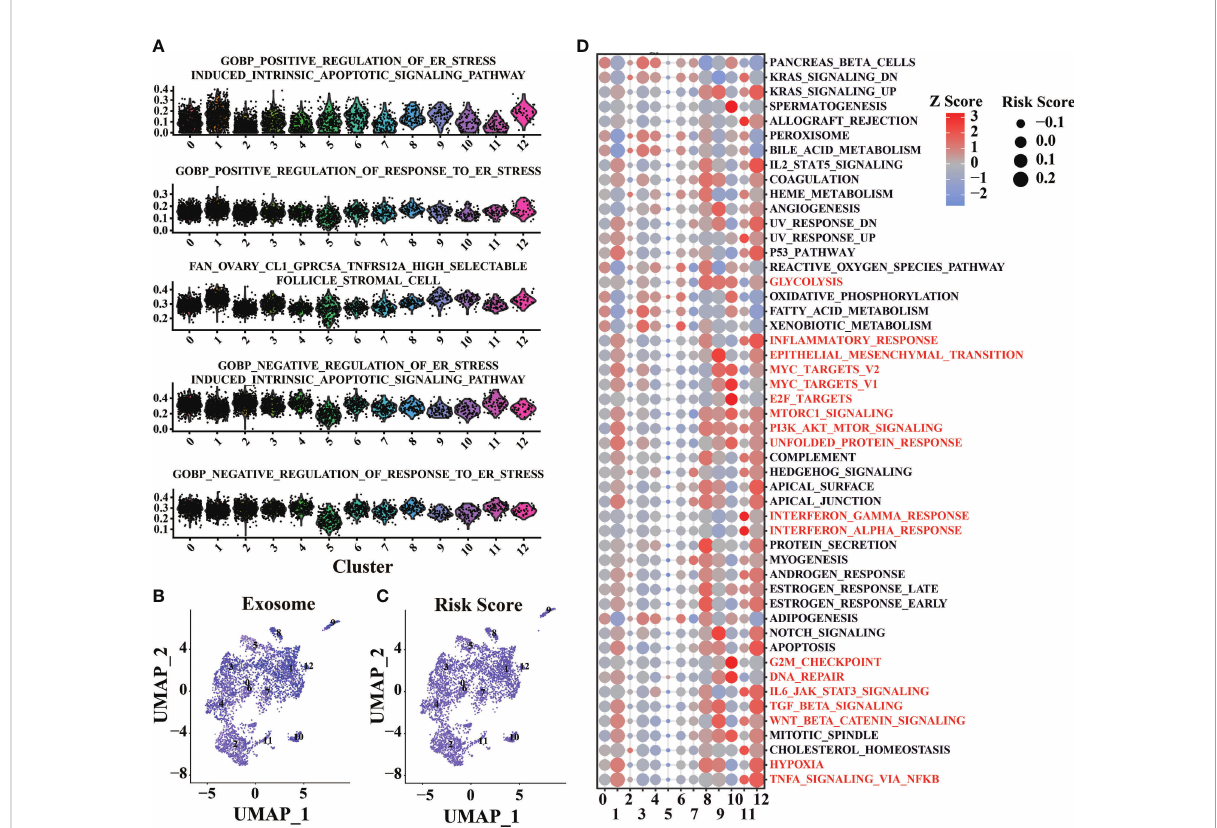
FIGURE 7 Functional enrichment of scRNA-seq base on the prognosis signature. (A) Enrichment analysis of ER stress-related gene sets was conducted by AUCell software. (B) Enrichment analysis of exosome related gene sets was conducted by AUCell software. (C) Use the prognostic signature to calculate the risk score of cells. (D) Enrichment analysis of tumor-associated Helmark gene sets was performed using